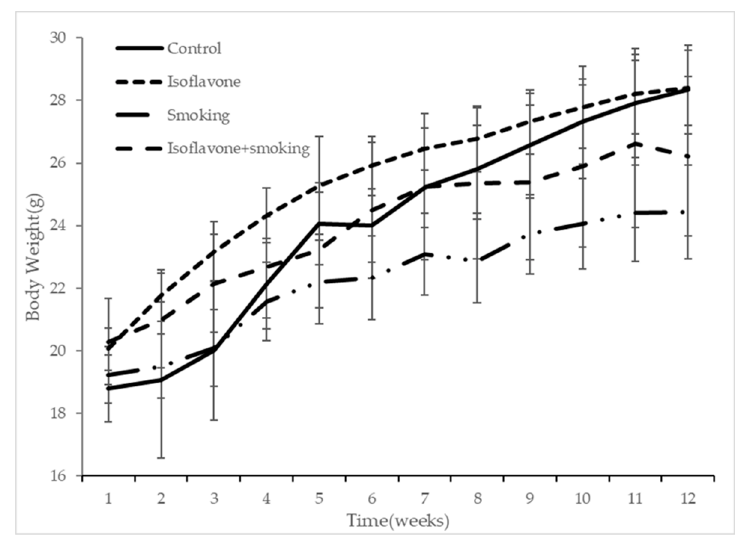
Figure 1. Body weight changes in each group. Control group; non-smoking with the normal diet (MF diet), ( n = 7), isoflavone group; non-smoking with the MF diet with DRIAs (daidzein-rich soy isoflavone aglycones), ( n = 10), smoking group; smoking with the MF diets, ( n = 8), and isoflavone + smoking group; smoking with the MF diet with DRIAs, ( n = 8). Values represent means ± SD. There are significant differences in the body weight between the control group and isoflavone group, and the smoking group and isoflavone group after 2 weeks.